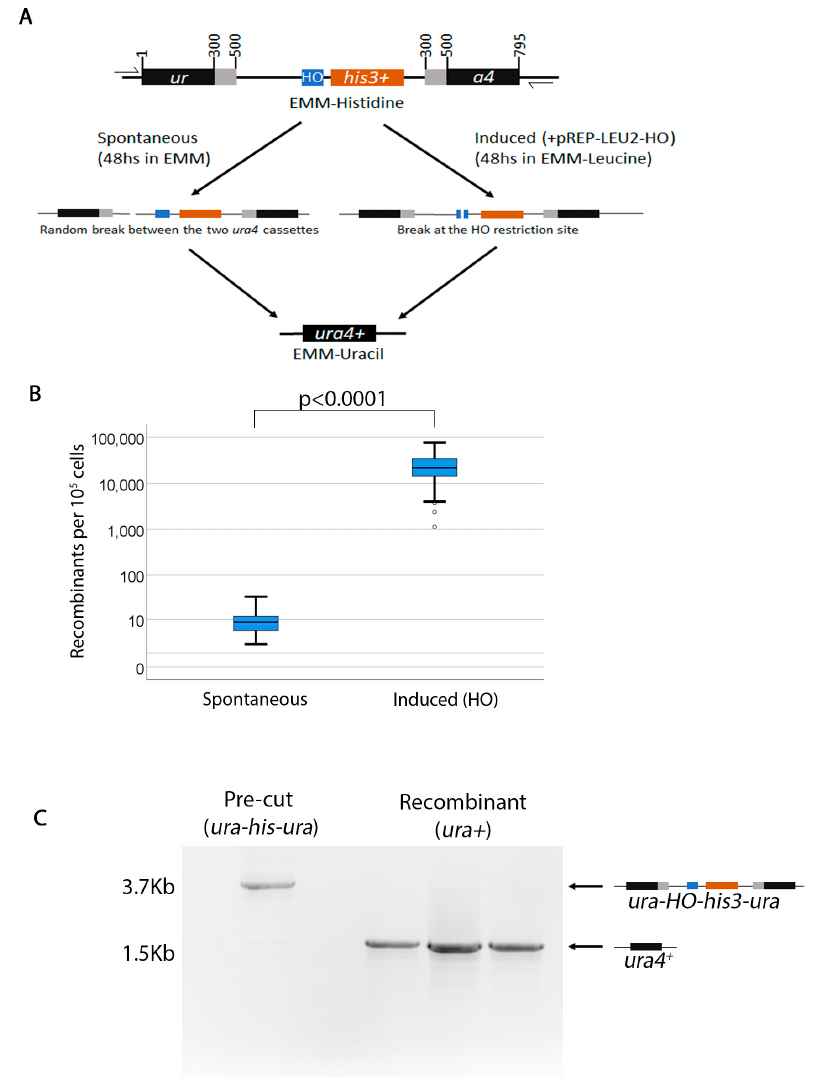
Figure 1. An assay to study spontaneous and induced double-strand breaks at regions of non-tandem repeats. ( A ). The ura-his-ura assay. In this assay, two non-functional ura4 alleles flank a functional his3 + allele. The ura4 alleles have 200 bps of identical overlapping sequences, creating two non-tandem repeats (gray areas). The S. cerevisiae homothallic endonuclease ( HO ) is cloned just upstream of the his3 + gene. The HO enzyme is on a LEU2 plasmid under the control of the nmt1 promoter which can be repressed with thiamine. Spontaneous ura4 + his3 - recombinants are assayed by growing cells in EMM+UraHisAdeLeu media for 48 h then plating on selective EMM-Uracil. Induced break recombinants are assayed by growing cells for 48 h in media without thiamine to de-repress the HO endonuclease, while maintaining selection for the plasmid (EMM-Leucine). Cells are then plated on EMM-Uracil. All experiments were performed at 32 ◦ C. ( B) . Box plot showing the frequency of recombinants for both induced and spontaneous breaks. ( C) . PCR across the ura-his-ura cassette in both pre- and post-recombination strains. Half arrowheads in ( A ) show approximate positions of